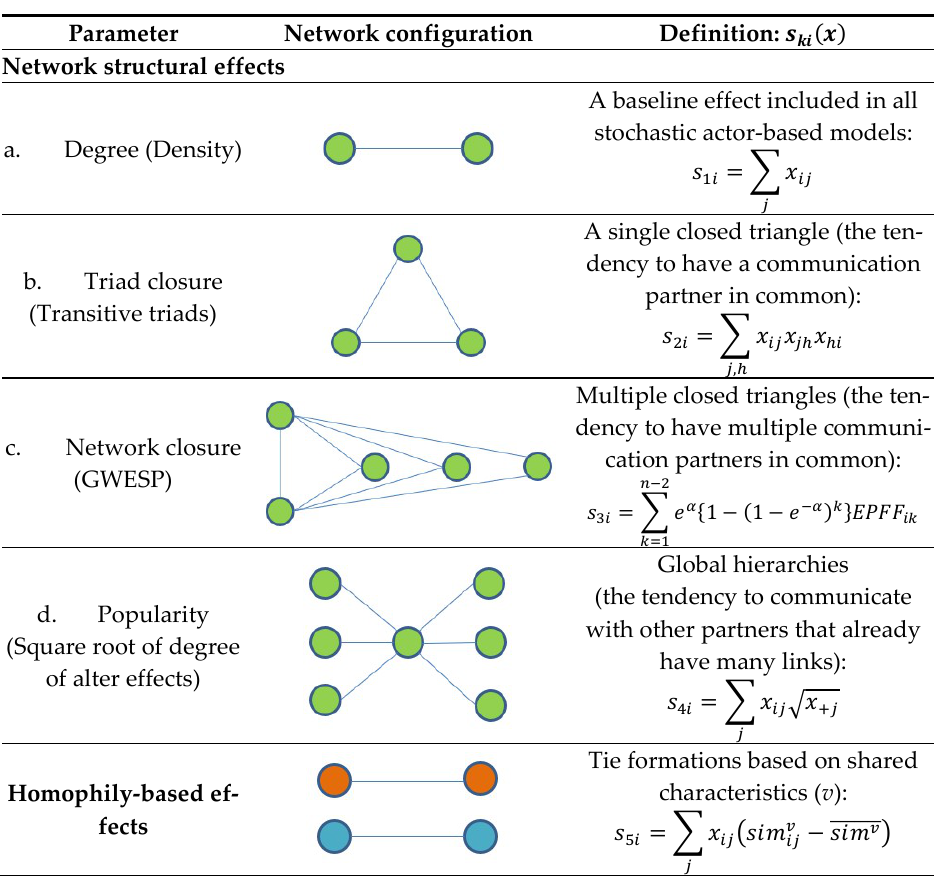
Figure 4. Configurations of the network structural effects and homophily for undirected communication ties tested in this study [30,32].